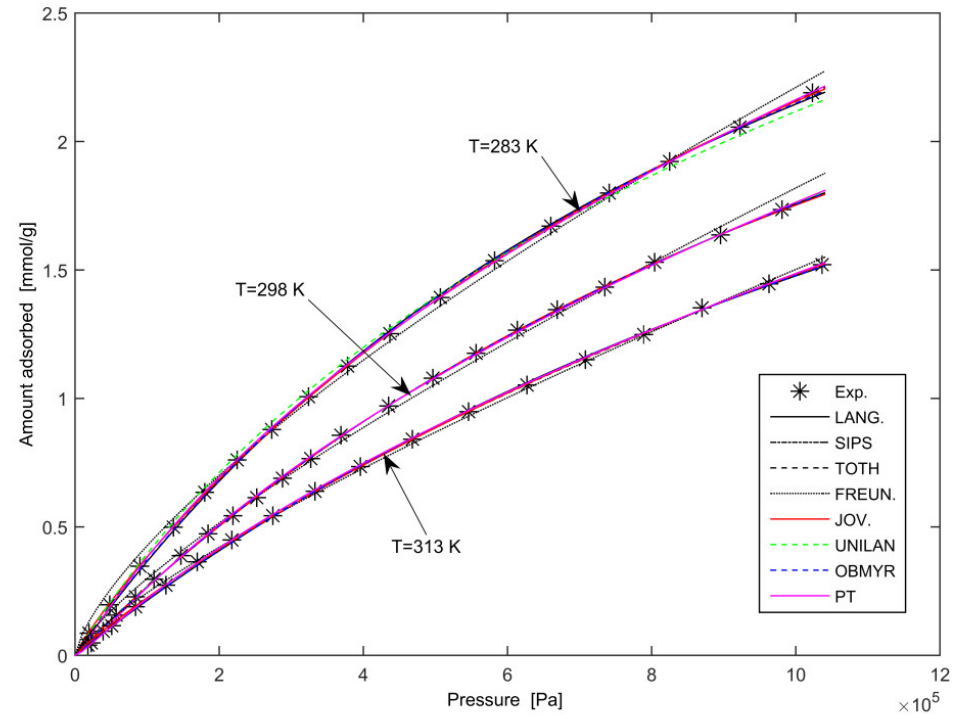
Figure 2. Pure-nitrogen adsorption results on activated carbon JX101.